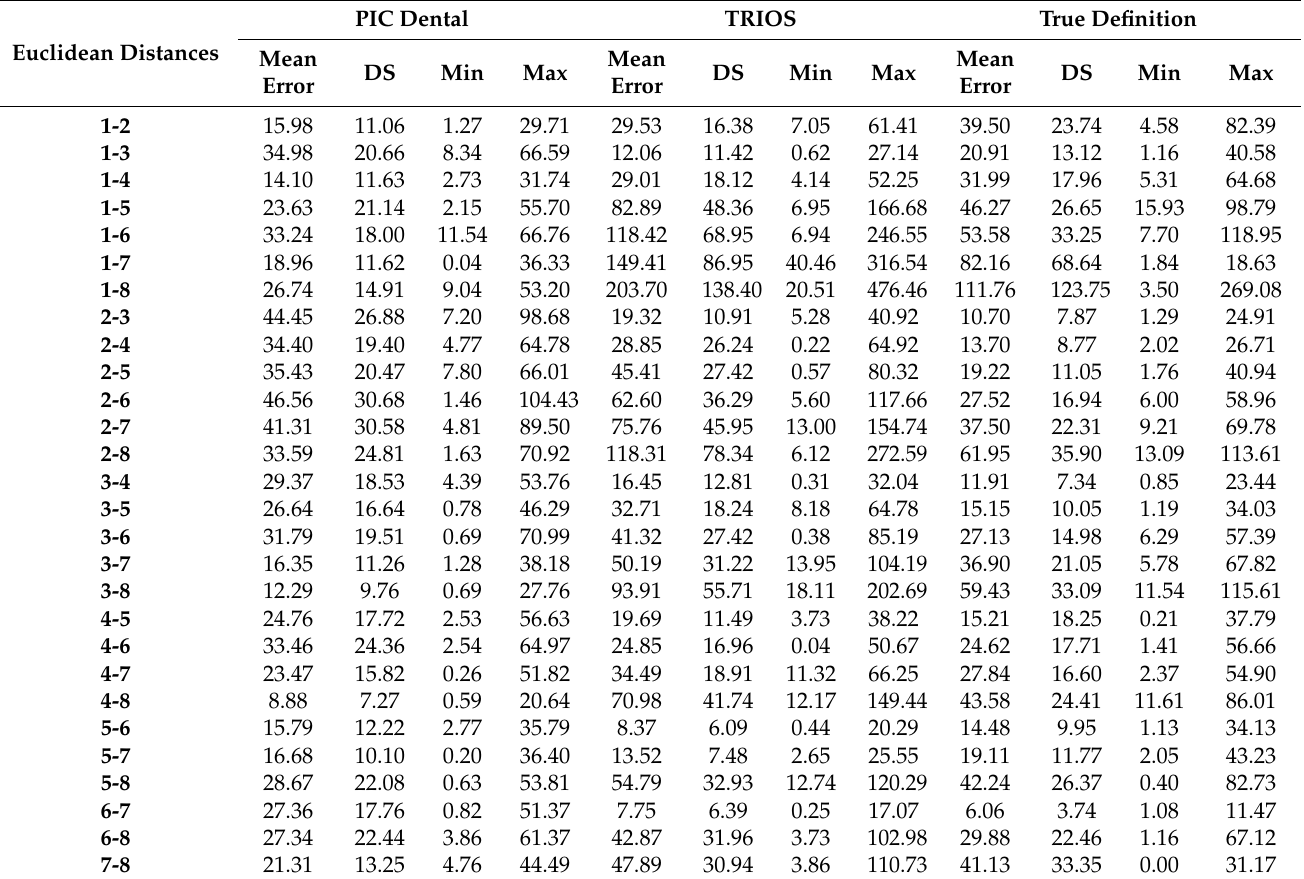
Table 2. Descriptive statistics for each of 28 Euclidean distances ( µ m) of mandibular arch obtained by the three systems